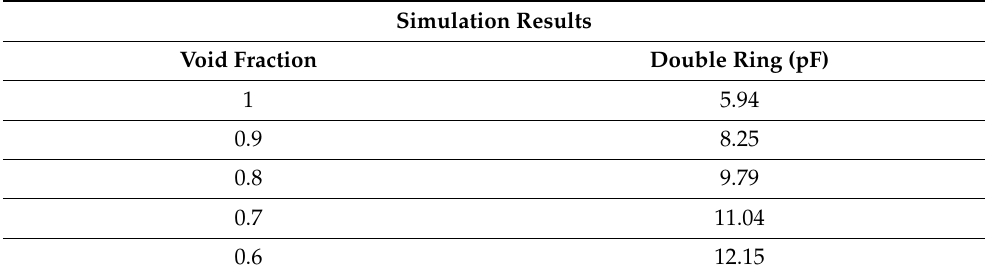
Figure 8. Simulated concave sensor along with its dimensions with the stratified two-phase flow where the blue color represents water level, the gray color represents the of the pipe, and the red and black colors represent the electrodes.